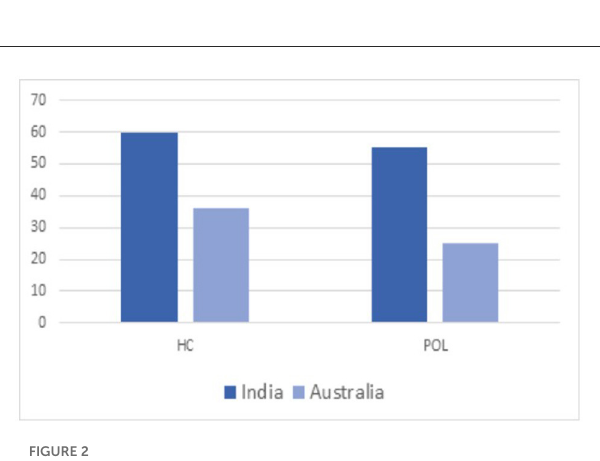
FIGURE2 Values of Hall’s indicators calculated for India and